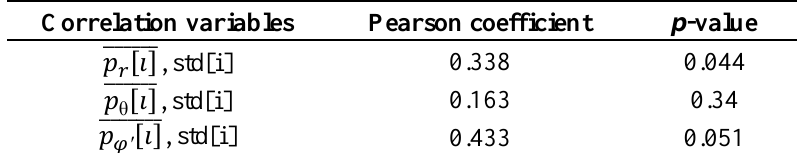
Table 2. Correlations between the dimensions of the spherical coordinate system and standard